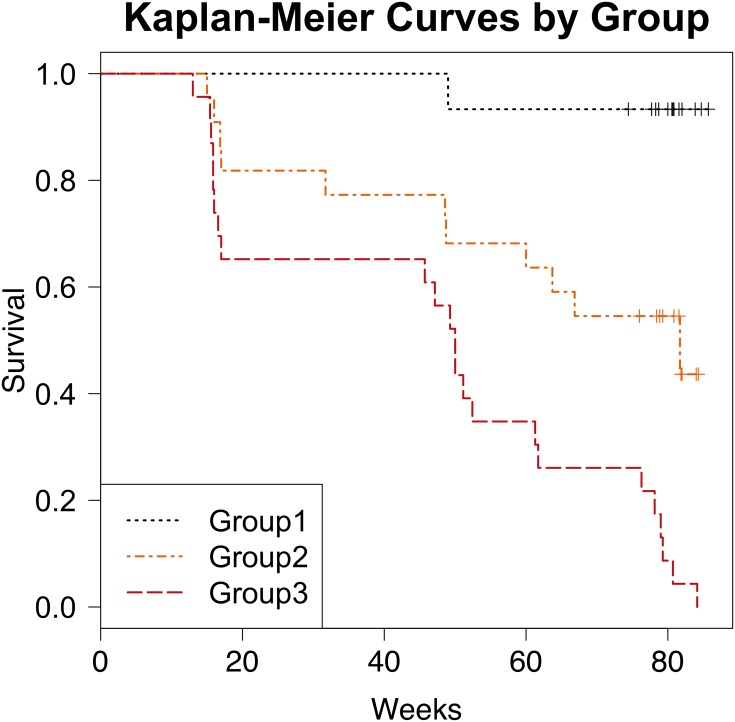
Kaplan-Meier curve showing progression free survival for patients according to the different severity groups in our weighted index score.In unadjusted analyses, A group level increasing by 1 using this index has a hazard ratio = 4.02, (95%CI 2.28–7.10), P<0.0001 for predicting IPF progression by univariate Cox regression model. In adjusted analyses, a group level increasing by 1 using this index has a hazard ratio = 4.06, (95%CI 2.17–7.60), P<0.0001 for predicting IPF progression by Cox regression model after being adjusted for age, gender, smoking status, baseline FVC percent predicted, baseline DLCO percent predicted and immunomodulation therapy.